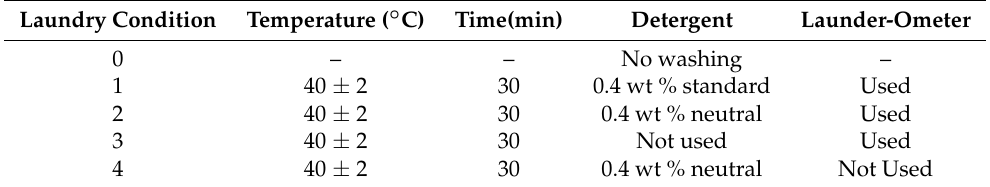
Table 1. Conditions set by following the Association of Textile Chemists and Colorists (AATCC) test method for washing in a laundry machine for textiles knitted using yarns based on pristine PAN fibers and nanocomposite fibers of PAN and conjugated polymer nanoparticles